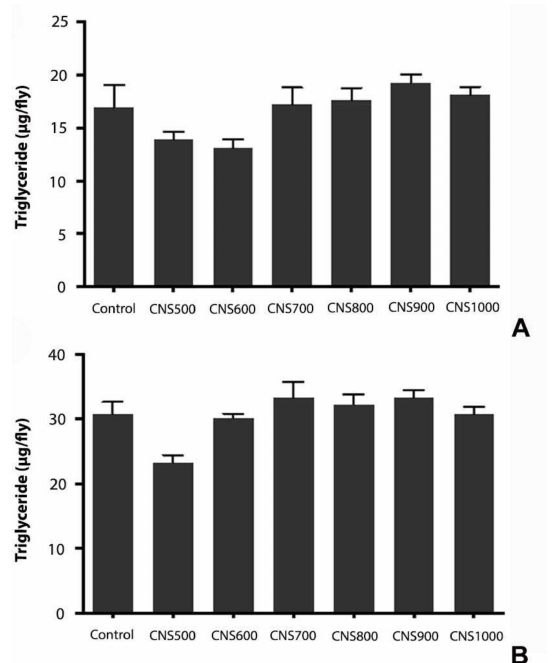
Figure 9. Estimation of triglycerides in response to dietary exposure to CNS500, CNS600, CNS700, CNS800, CNS900, and CNS1000 CNSs for 25 days at 1000 µ g/mL dose in ( A ) male and ( B ) female flies. The values are represented as mean ± SEM and statistical significance was set at p < 0.05 when compared to control (n = 3 and 25 flies per treatment